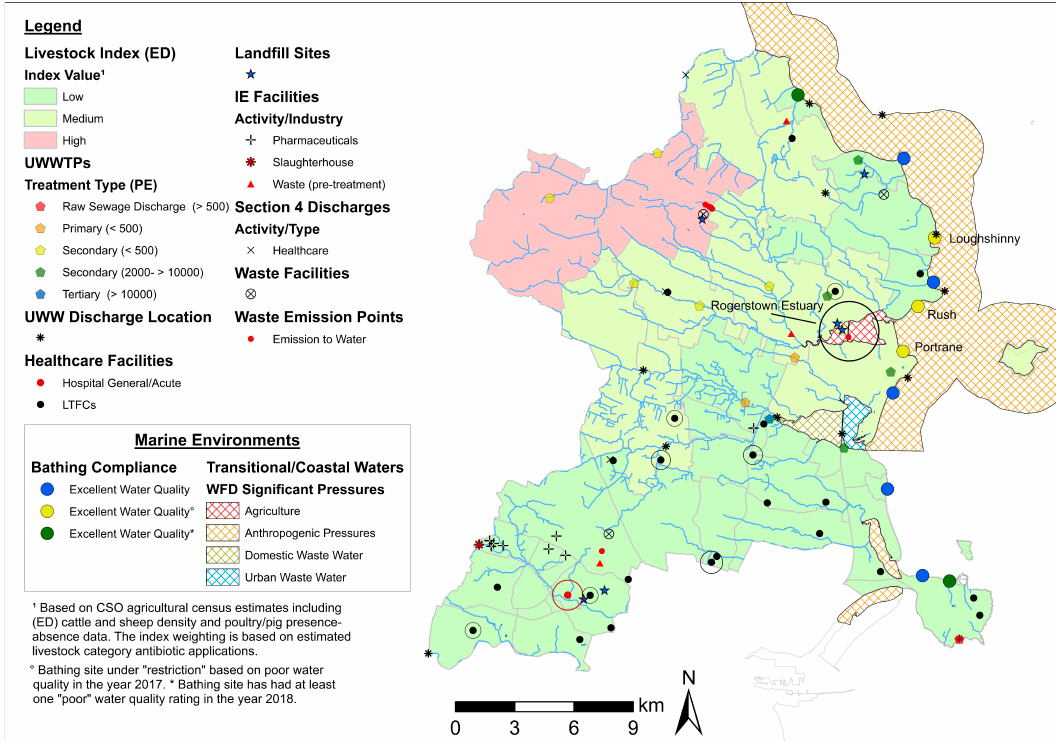
Figure 8. Map of all potential ARO sources and transmission routes in Fingal County. Notes: Livestock index estimates, hydrology (inland waters), EPA-WFD coastal/transitional significant pressures and bathing site compliance data layers are included. Buffers around healthcare facilities reflect rates of AM use/consumption (red = hospital/general acute; black = LTCFs). Relevant areas including the Rogerstown Estuary and bathing sites are highlighted. ED = electoral district. UWWTPs = urban wastewater treatment plants. UWW = urban wastewater. IE = industrial emissions. PE = population equivalent (i.e., estimated population served by